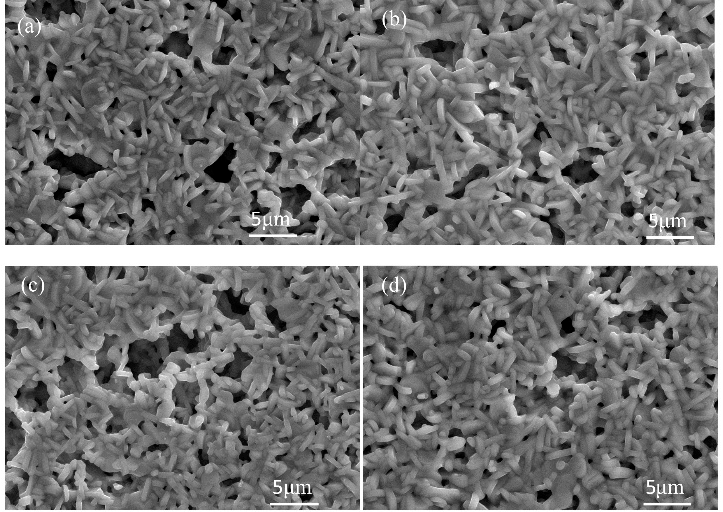
Figure 6. SEM images of LNT with various Ti content at 1273 K for 1 h under 0.35 MPa. ( a ) 15 mol %,